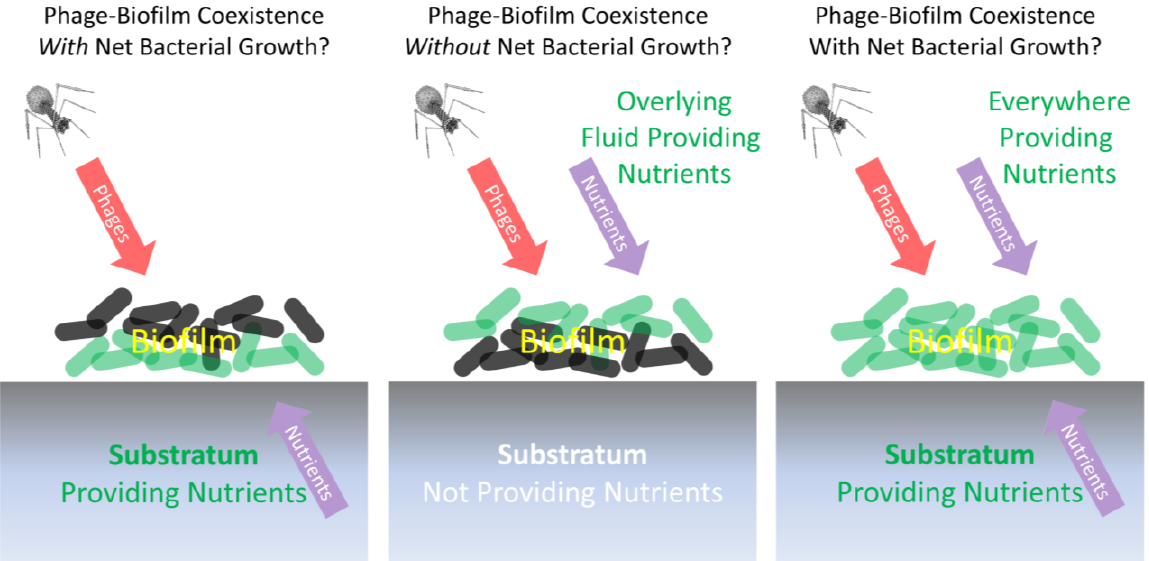
Figure 4. Different scenarios for biofilms limiting (left and right) or not limiting (middle) net phage exploitation despite substantial ongoing bacterial replication. Those bacteria that are more metabolically active are shown as green (bottom layer on the left, top layer in the middle, and all layers on the right), while less metabolically active bacteria are illustrated as a dark gray. If nutrients and phages come from different spatial directions (left; the Eriksen et al. [80] experimental model), then ongoing bacterial growth may be possible despite biofilm exposure to phages. If phages and nutrients come from the same direction (middle; inert substratum model), then ongoing bacterial growth may